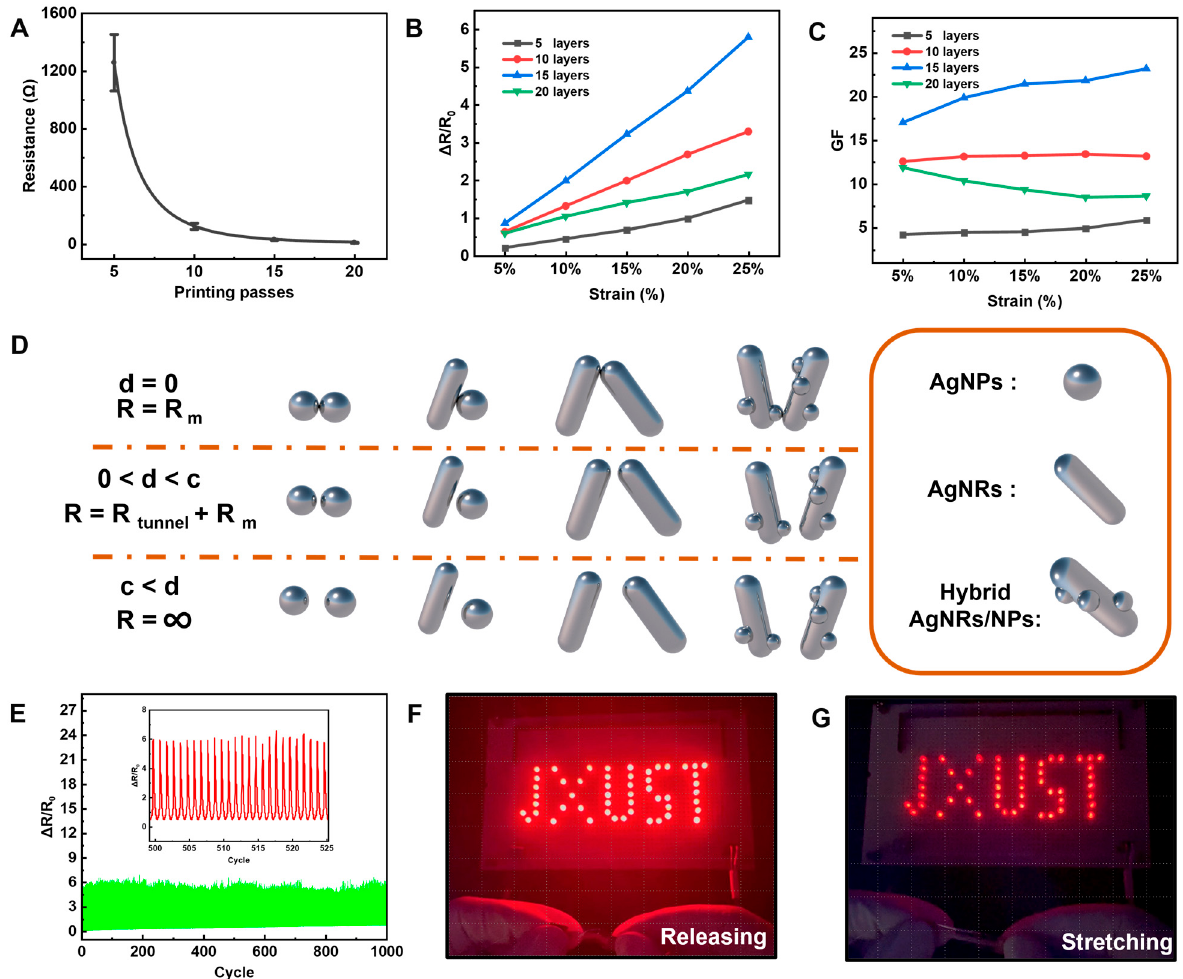
Figure 3. Sensing performance and mechanism investigation. ( A ) Variation in resistance of the 3D networks-based sensor as a function of printing passes. ( B ) Relative resistance changes of the sensors with different printing layers under stretching. ( C ) GF changes of the sensors with different printing layers under stretching. ( D ) The model of different electrical interconnections between AgNRs and AgNPs. ( E ) Cyclic stretching and releasing tests of the sensors. ( F,G ) Bright variation in brightness of the connected LEDs under releasing and stretching states.